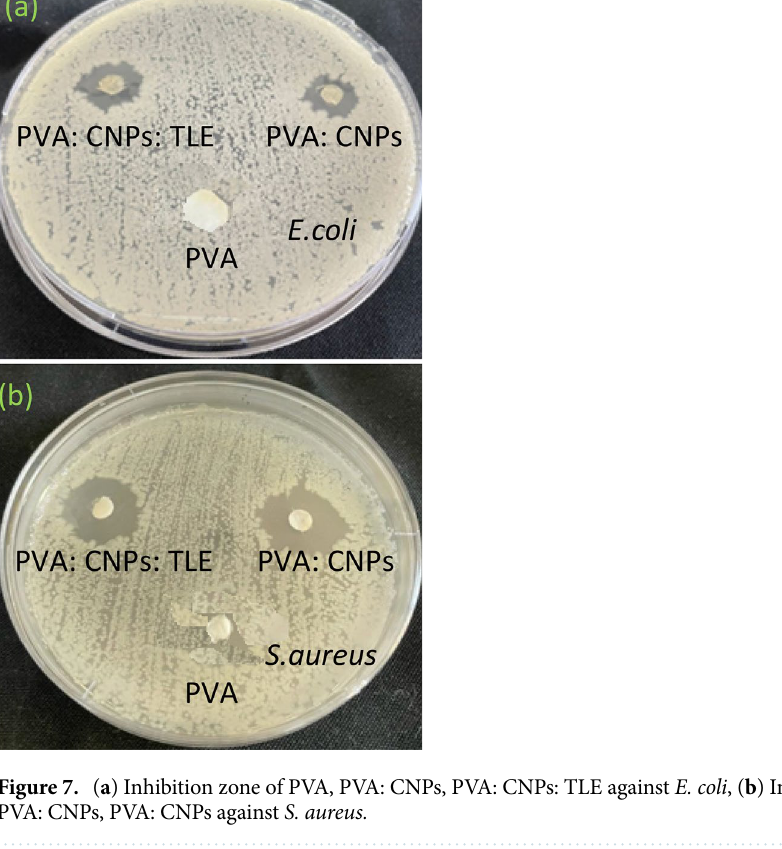
Zone of inhibition (mm) E. coli S. aureus